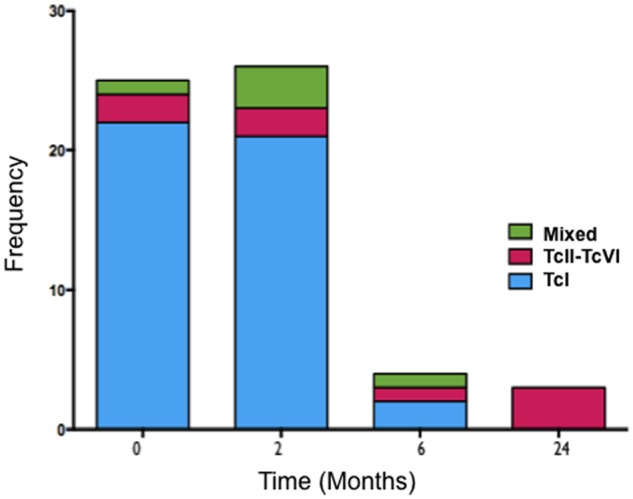
Pre and post-treatment distribution of T.cruzi Discrete Typing Units (DTUs).